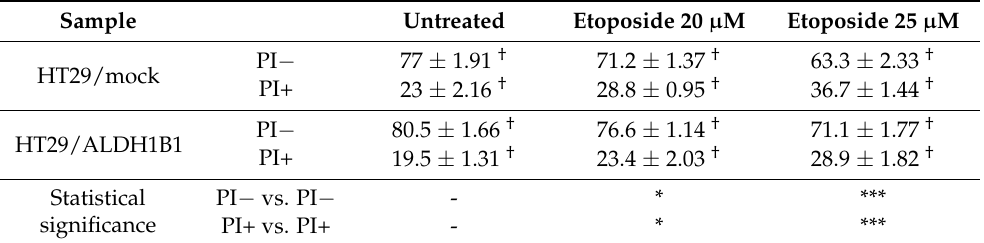
Table 6. Percentage (%) of unstained and propidium iodide (PI)-stained cells under normal and etoposide